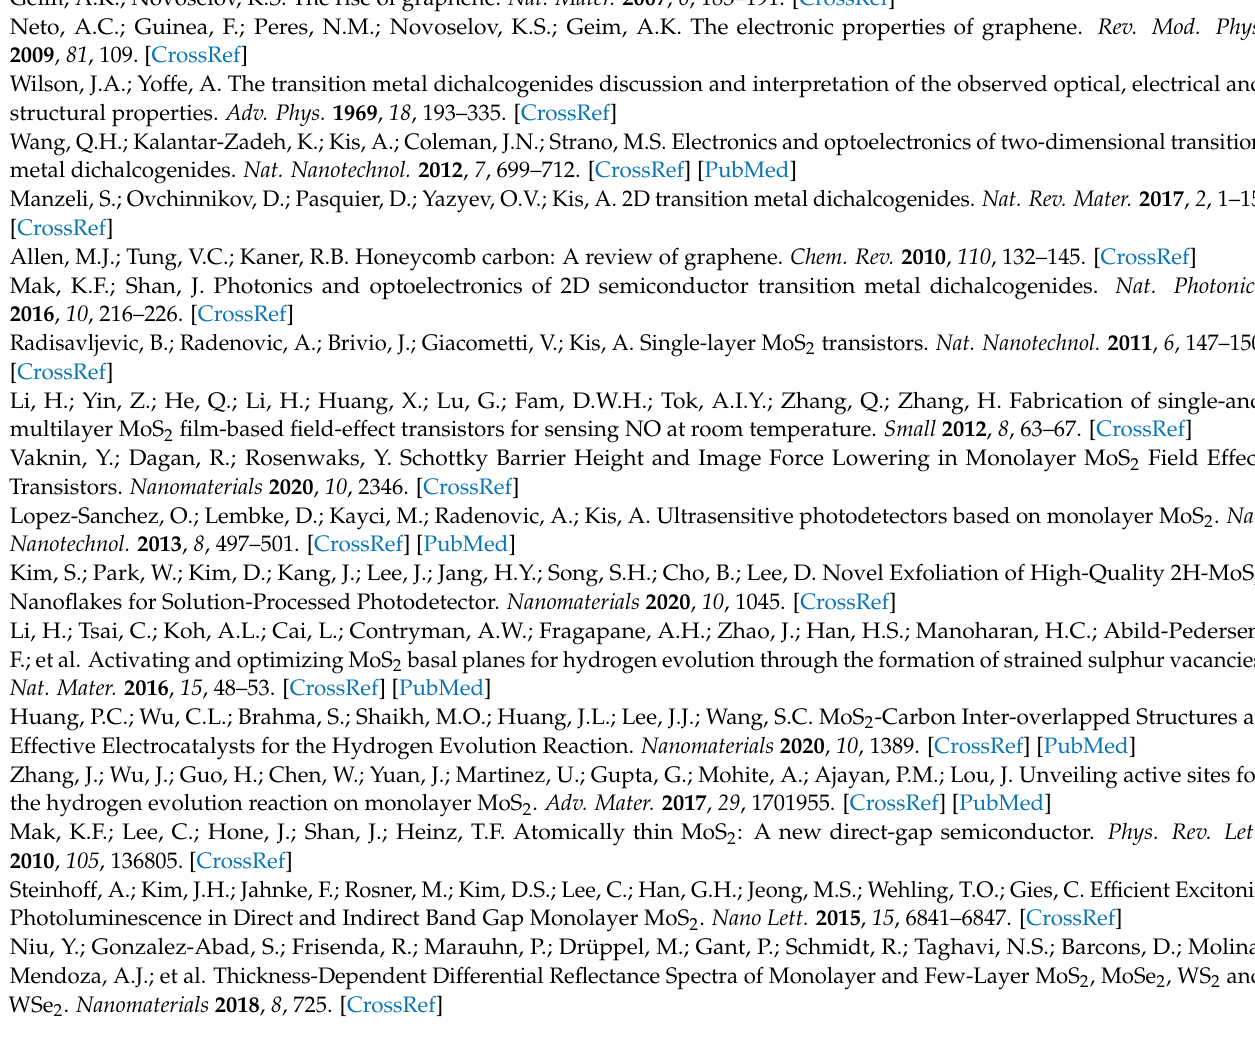
CVD growth, Figure S5: MoO 2 -MoS 2 nanoplates grown after the carbon cloth-assisted CVD growth and after the conventional CVD growth, Figure S6: Additional AFM data of monolayer MoS 2 synthesized using the carbon cloth-assisted CVD method, Figure S7: Size distribution of monolayer MoS 2 synthesized at reaction times of 5 min, 15 min, and 20 min using the carbon cloth-assisted CVD method, respectively, Figure S8: Graphite powder-assisted CVD growth of monolayer MoS 2 , Figure S9: Monolayer WS 2 synthesized on a c-cut sapphire substrate using the conventional CVD method and the carbon cloth-assisted CVD